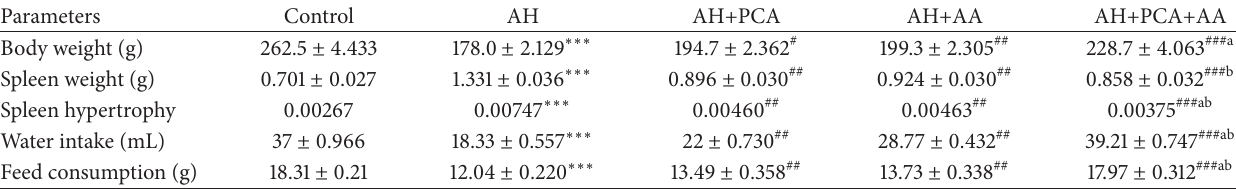
Table 1: Effect of PCA alone and in combination with AA on body weight, spleen weight, water intake, and feed consumption.